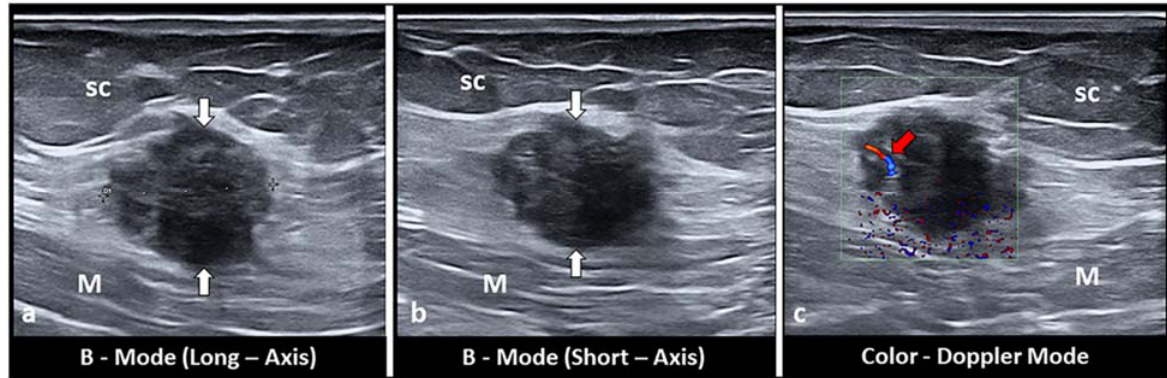
Figure 3. Long-axis ( a ) and short-axis ( b ) sonograms show a hypoechoic, nodular mass (white arrows), located between the subcutaneous tissue (sc) and the muscular plane (M) of the abdominal wall. Of note, fine intralesional, vascular spots (red arrow) are depicted on the color Doppler ( c ).